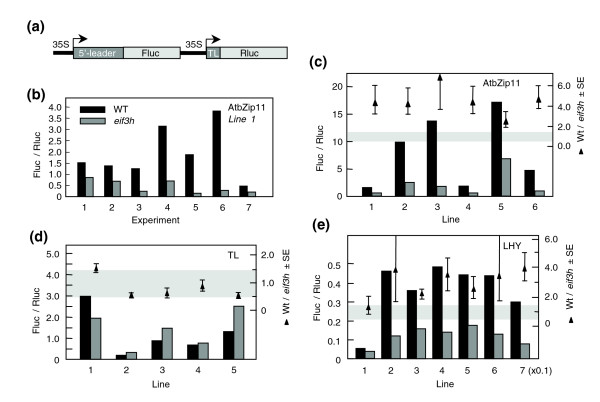
eIF3h controls the translational efficiency of the AtbZip11 leader in stable, transgenic, reporter gene expression cassettes. (a) Schematic of the reporter gene T-DNA structure. The efficiency of translation initiation on a given 5' leader sequence is measured by comparing the activity of the associated firefly (Fluc) reporter gene with the activity of the Renilla luciferase (Rluc) reference gene, which is expressed under the control of the cauliflower mosaic virus 35S promoter (35S) and the generic 5' leader sequence from tobacco etch virus (TL). (b) Translational efficiency of the AtbZip11 (ATB2) leader in wild-type (WT) and eif3h mutant seedlings. Seedlings were germinated for nine days on solid agar medium in the light. The figure shows raw Fluc/Rluc activity ratios from seven individual experiments conducted with one transgenic line. The data are representative of other raw data that underlie Figure 1c-e and Figure 2. (c) Translational efficiency of the AtbZip11 leader in wild-type (WT) and eif3h mutant seedlings. All six independent transgenic lines examined are shown. The bars indicate Fluc/Rluc ratios (left y-axis), while the triangles show the ratio of translational efficiency between wild-type (Wt) and mutant plants (right y-axis). The Wt/eif3h bracket between 0.5 and 1.5 is highlighted in gray to facilitate comparison between panels. SE, standard error. (d) Translational efficiency of the tobacco etch virus leader (TL) in wild-type (Wt) and eif3h mutant seedlings. Data from five lines are displayed as for (c). (e) Translational efficiency of the leader of the Arabidopsis LHY (At1g01060) gene. Fluc/Rluc bars for line 7 are displayed at 10% of the original values.